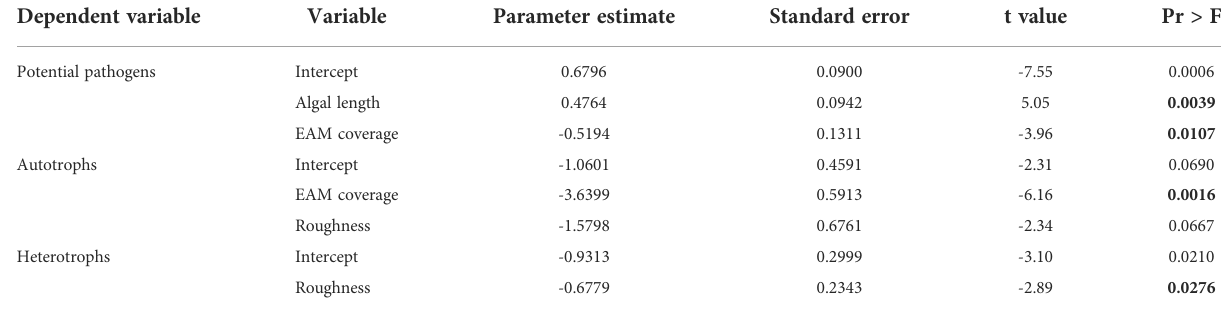
TABLE 2 Summary of stepwise regression analysis parameter estimation